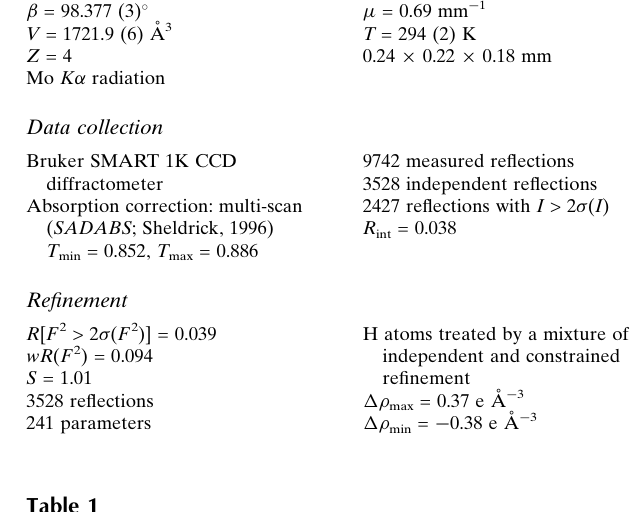
Hydrogen-bond geometry (A˚ , (cid:3)